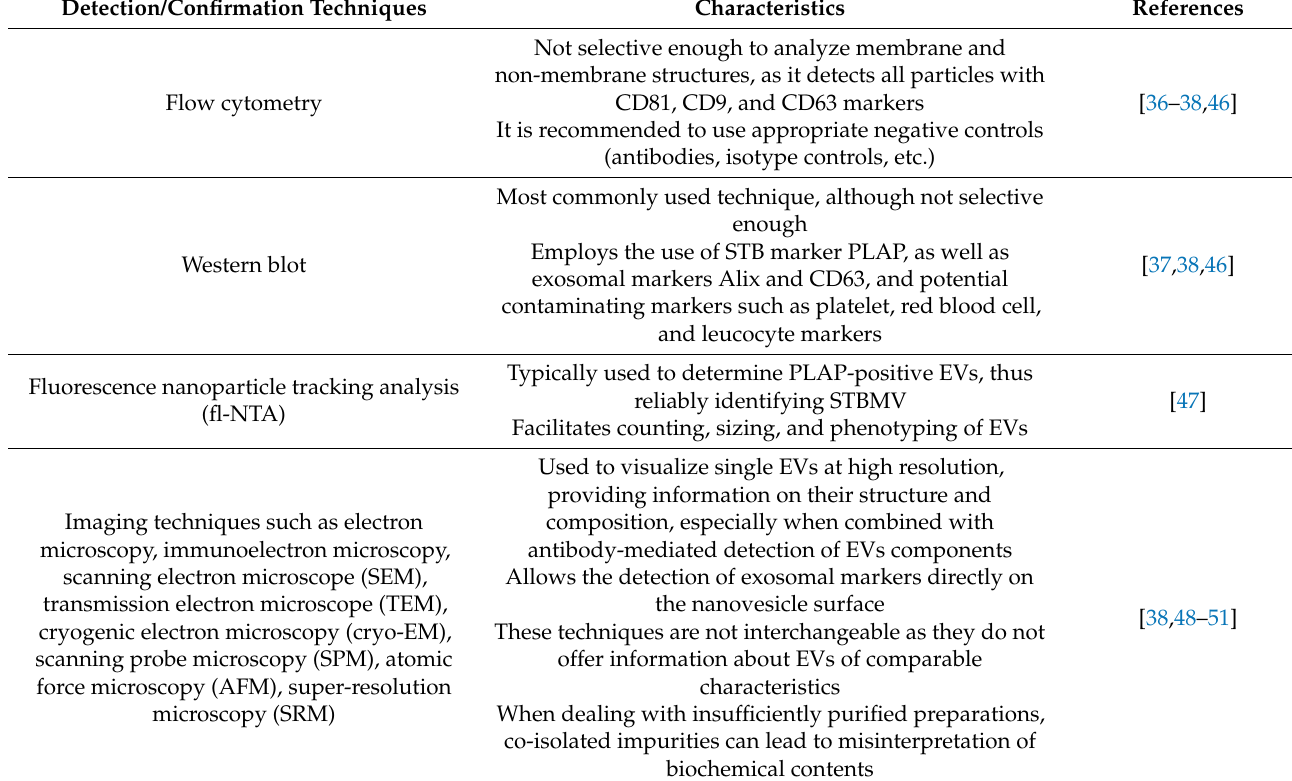
Table 3. Methods for the detection and confirmation of pregnancy-related